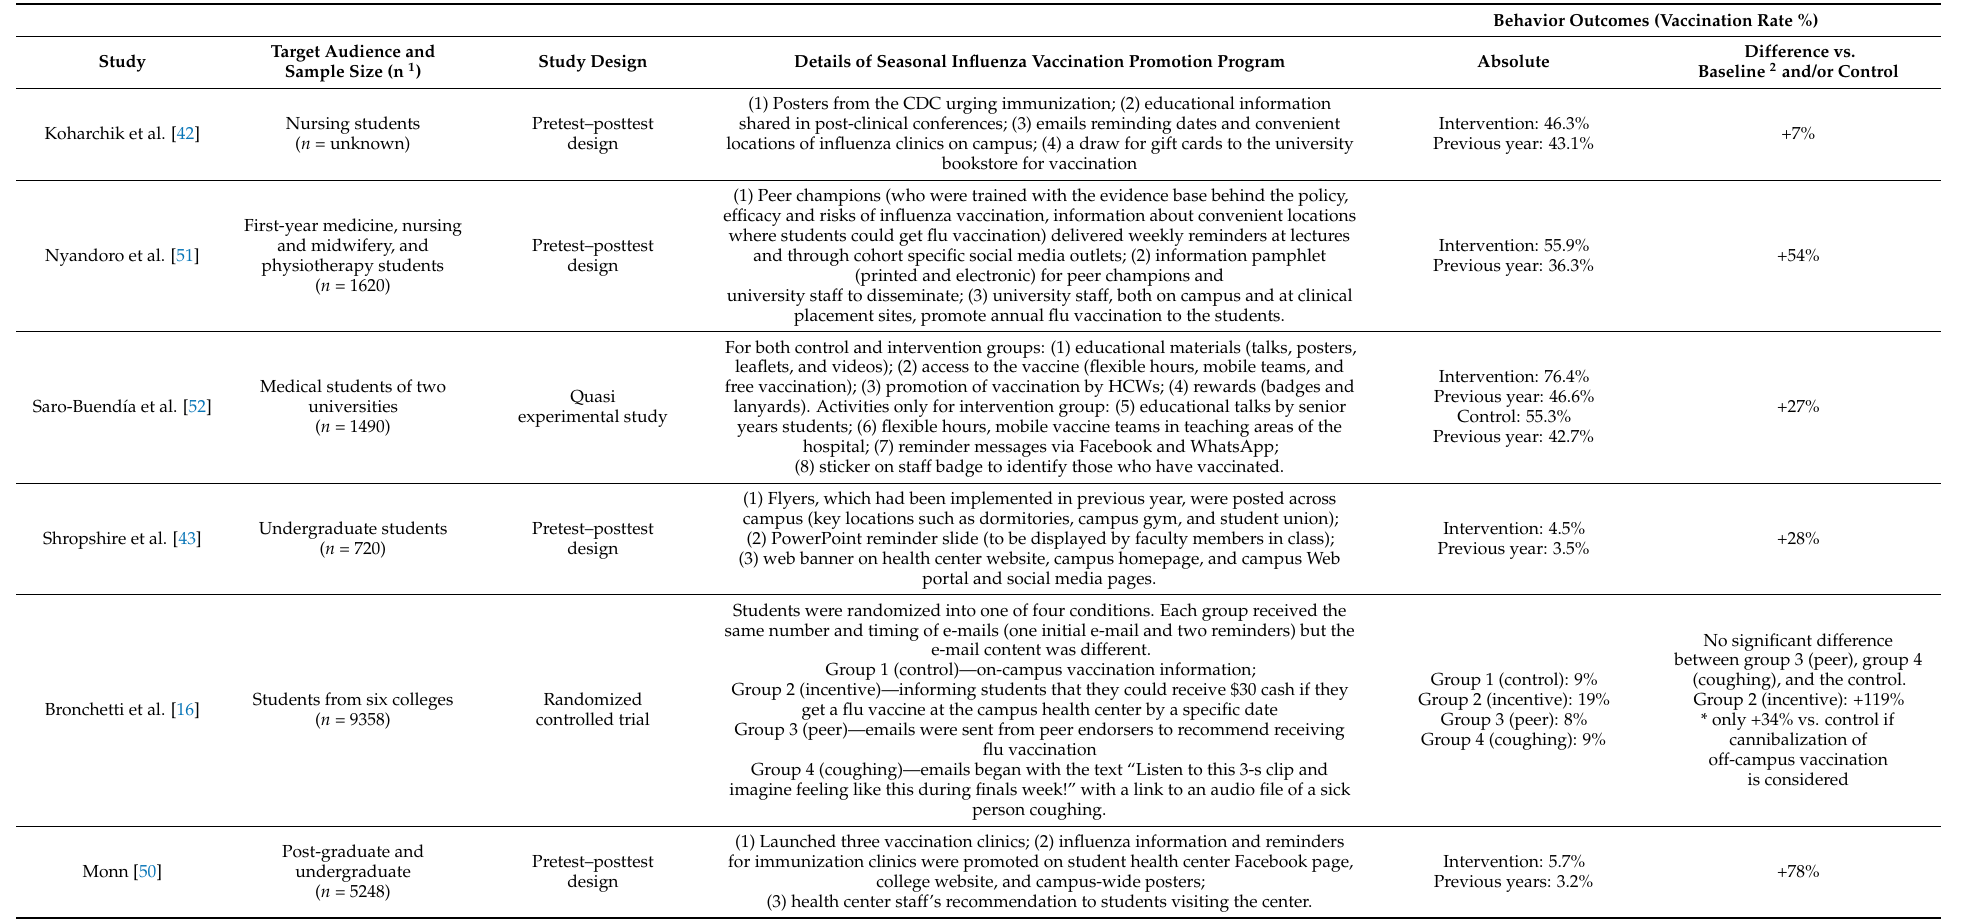
Table 2. Details of seasonal influenza vaccination programs and behavior